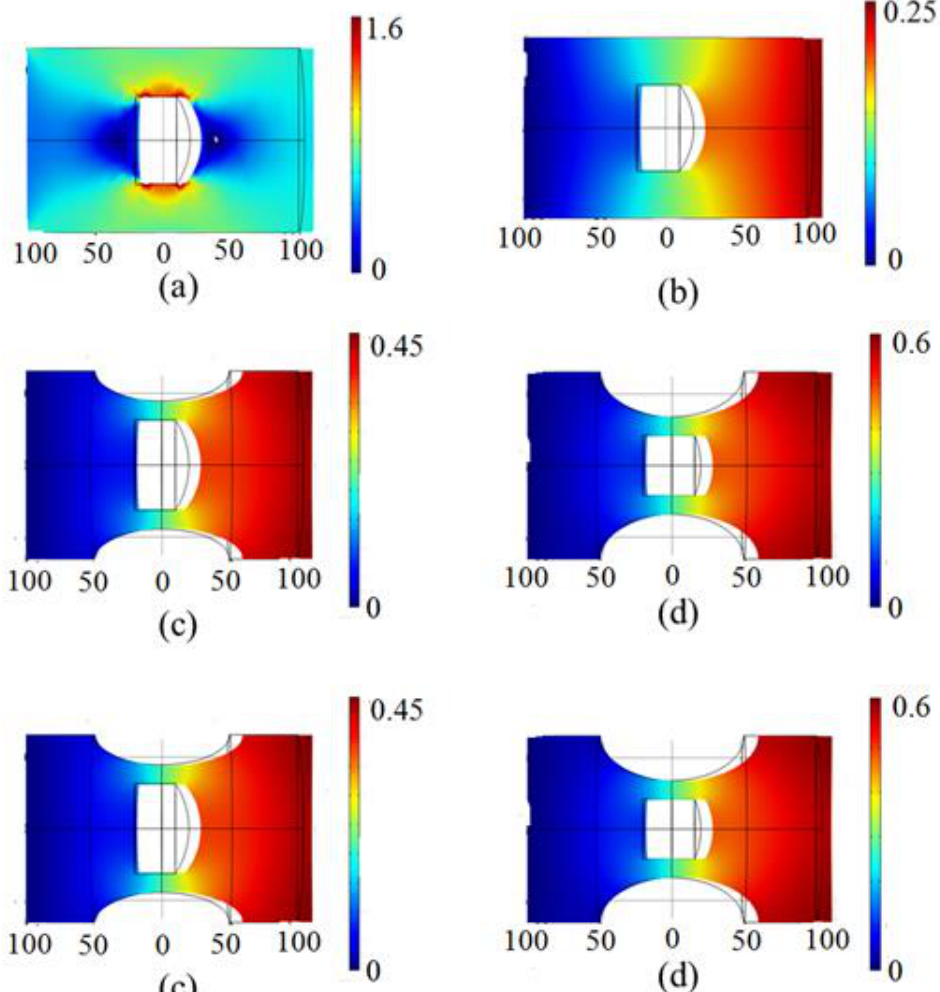
Figure 10. The simulation diagram of the microcavity model. ( a ) ψ = 60 µ m, γ = 32.5 µ m. The stress distribution of the stress distribution field (unit: N/m 2 ); ( b ) ψ = 60 µ m, γ = 32.5 µ m. The displacement distribution field (unit: µ m); ( c ) ψ = 60 µ m, γ = 10 µ m. The stress distribution of the stress distribution field (unit: N/m 2 ); ( d ) ψ = 40 µ m, γ = 10 µ m. The displacement distribution field (unit: µ m). ( e ) The relationship between ∆ L / L and different values of cavity wall and cavity diameter.